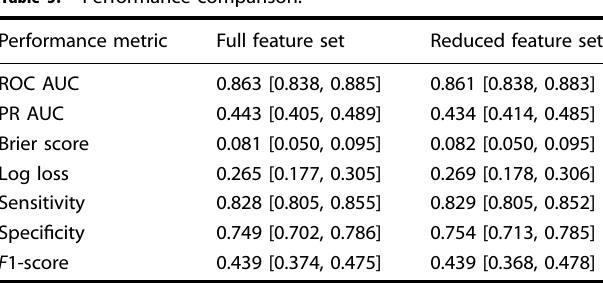
Different test set performance metric distributions across splits for the models before and after feature reduction based on feature importance. Numbers are reported as median and interquartile